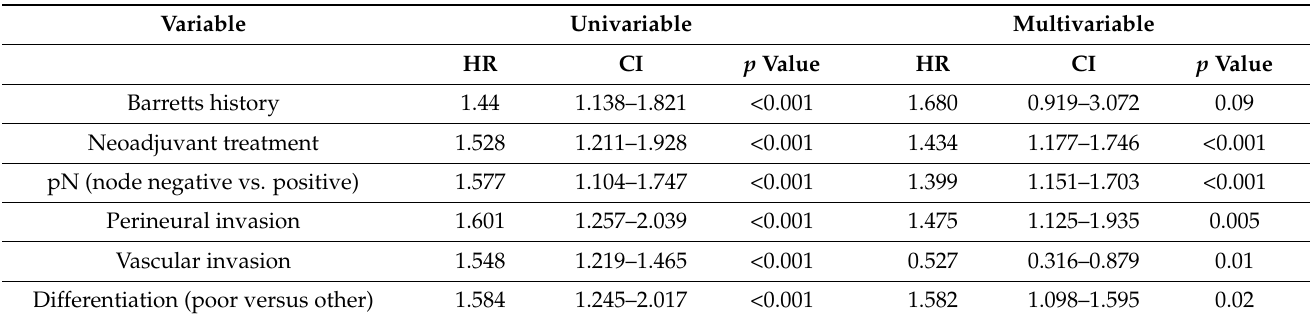
Table 2. Univariable and multivariable analysis for overall survival.